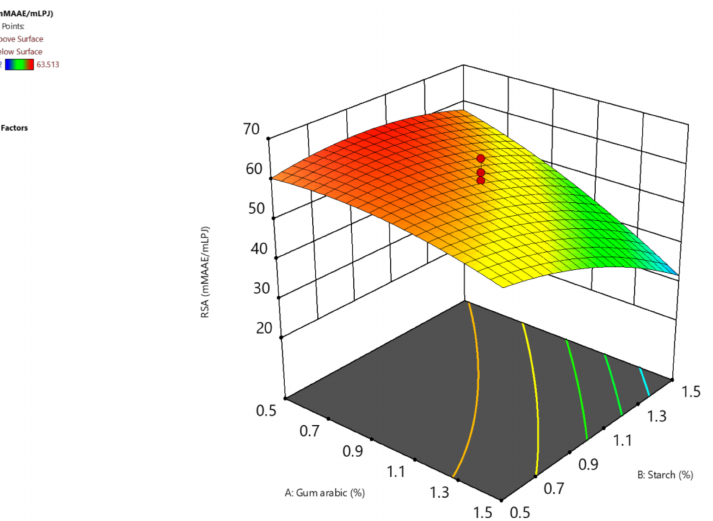
Figure 5. Response surface plot for radical scavenging activity (mMAAE/mL PJ) of coated “Wonder- ful” pomegranate as a function of gum arabic and maize starch and